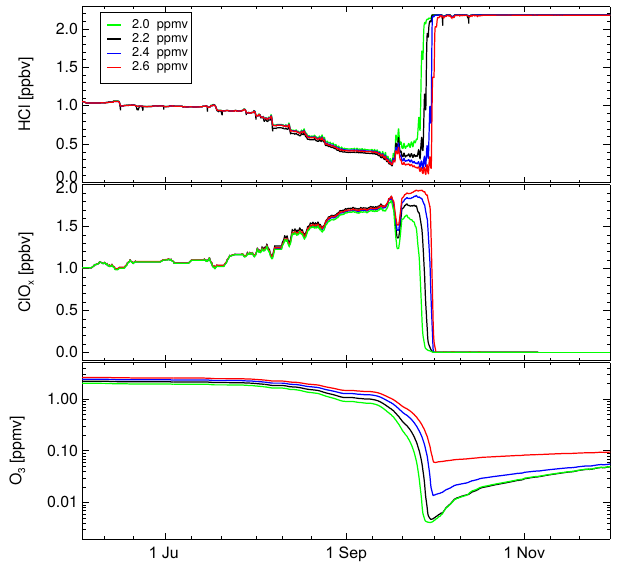
Figure A1. Simulations for different initial ozone mixing ratios. Simulation as in the reference run but with different initial ozone mixing ratios (2.0 to 2.6ppm).